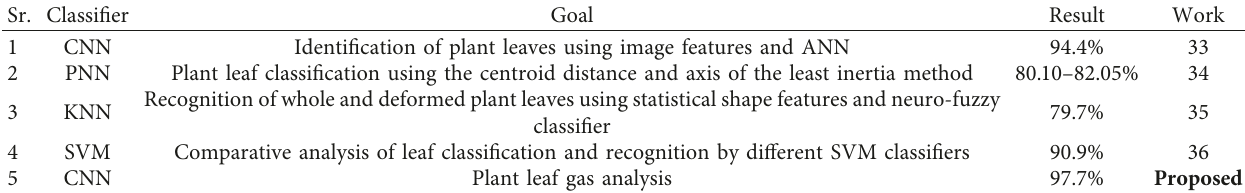
Table 4: Performance